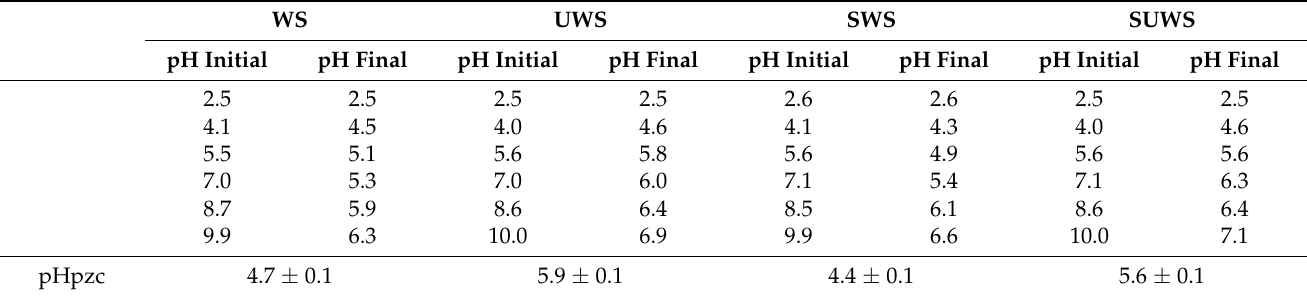
Table 3. Initial and final pH of solutions for point zero charge determination of